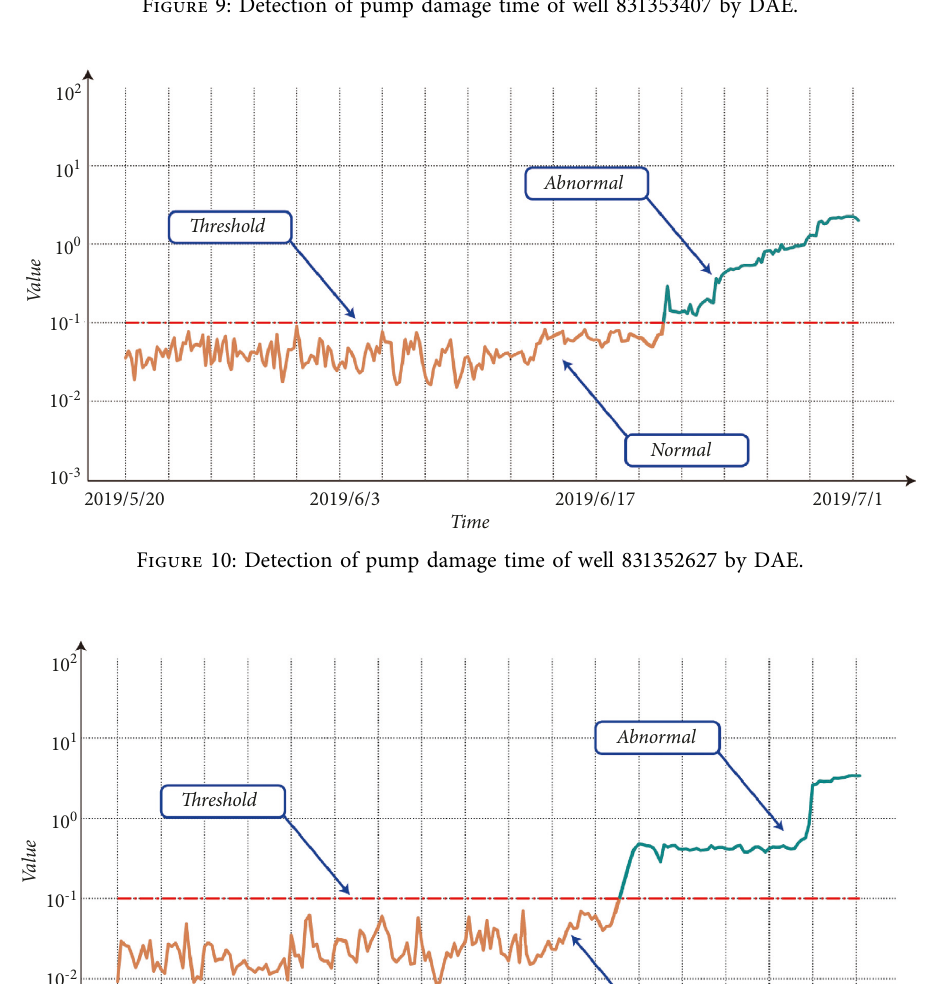
Figure 9: Detection of pump damage time of well 831353407 by DAE.